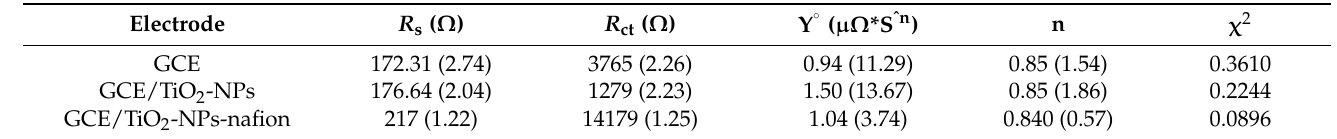
Table 3. EIS data obtained on various electrodes in 5 mM [Fe (CN)6] 3−/4− solution at +0.2 V fixed potential.